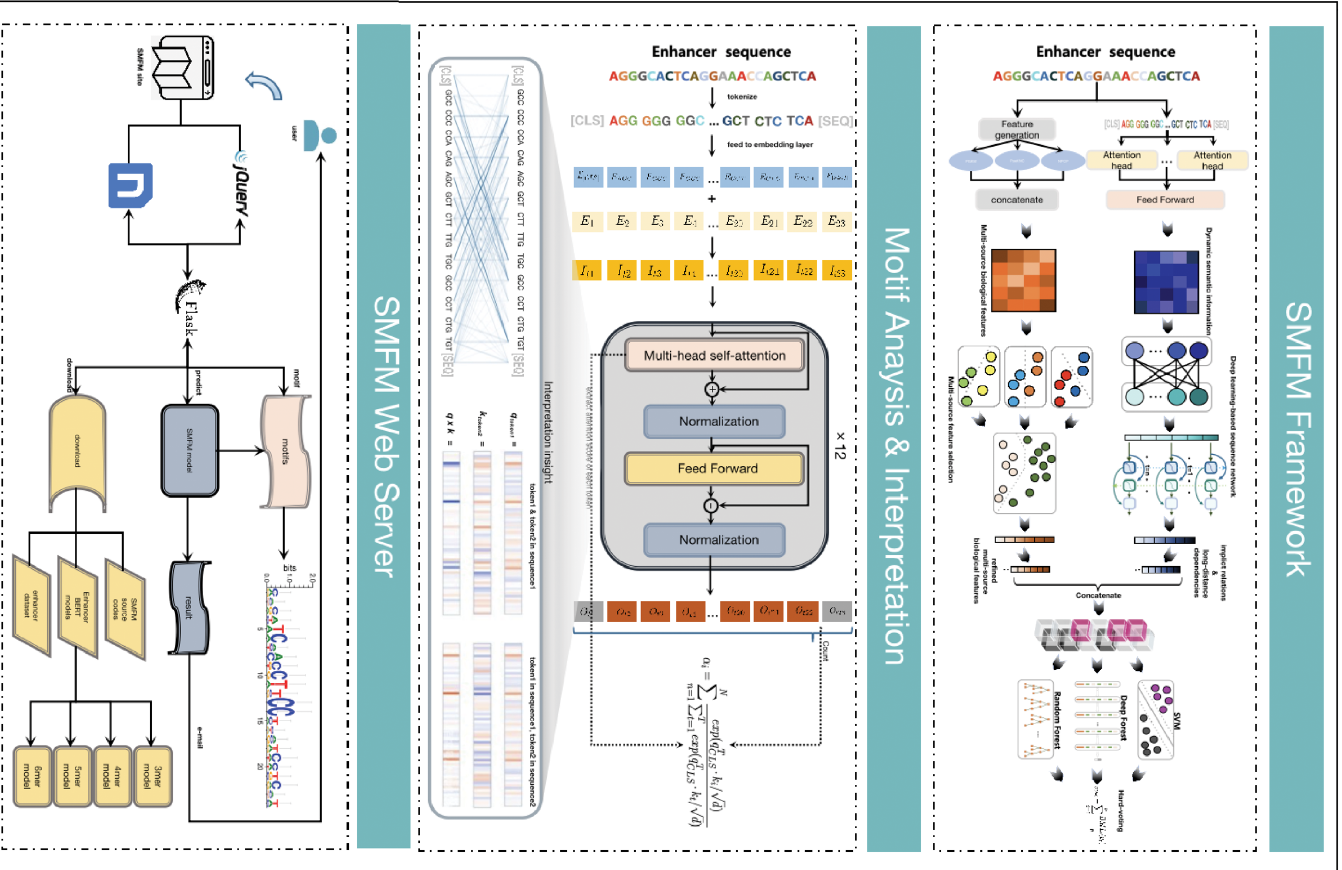
Fig 2. (a) The overall framework of SMFM. First, enhancer sequences are generated as multi-source biological features and dynamic semantic information utilizing multi- source feature generation and EnhancerBERT, which are then fed into a multi-source feature selector and deep learning-based sequence network, respectively. Finally, the streamlined information is combined as input for the ensemble machine learning classifier to produce the final prediction results. (b) The motif analysis for EnhancerBERT and corresponding interpretation. We extract the attention heads of EnhancerBERT to calculate attention scores of each token, and motifs are found by using filter conditions of attention scores. Corresponding interpretations are performed to analyse attention process of EnhancerBERT and the regions that EnhancerBERT concentrated on. (c) The workflow and function display of the SMFM web server. The web server has three functions: predicting enhancer sequences, motif analysis pipeline and downloading EnhancerBERT models and source codes of